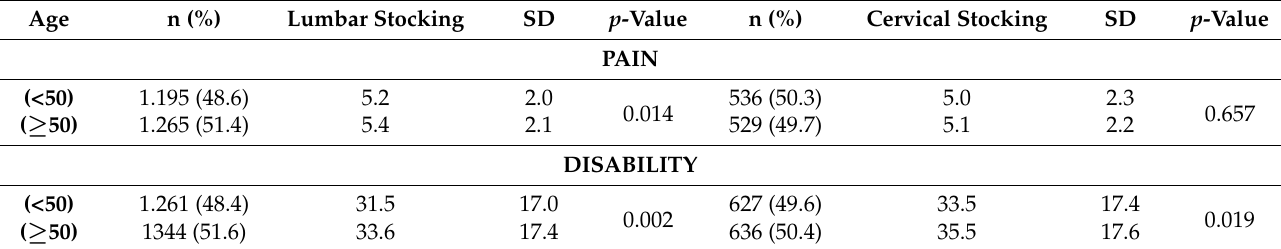
Table 2. First assessment of BS: pain and disability as a function of